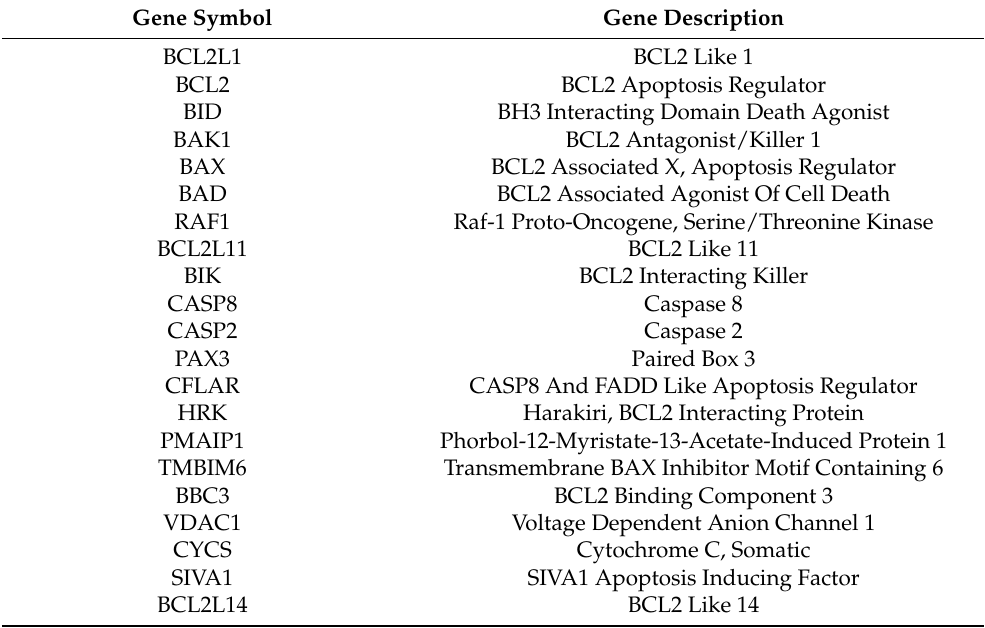
Table 1. Gene symbols and description of the BCL-xL interactome members.